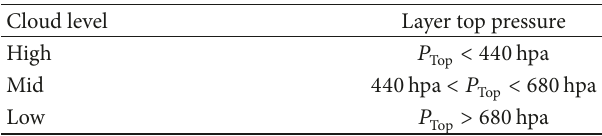
Table 1: Classification of cloud